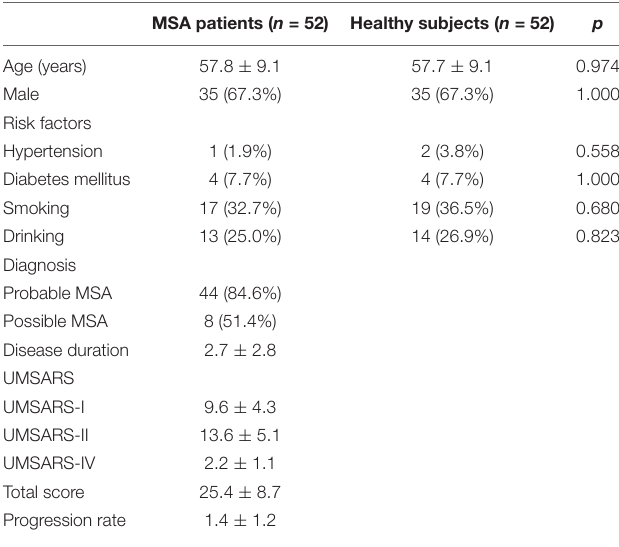
TABLE 1 | The clinical characteristics of MSA patients and healthy